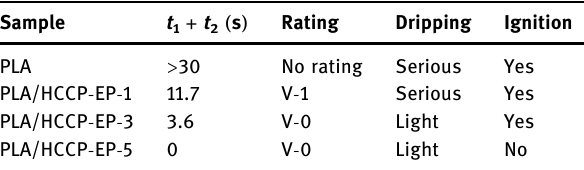
Table 1: The results of UL - 94 tests for PLA/HCCP - EP blends